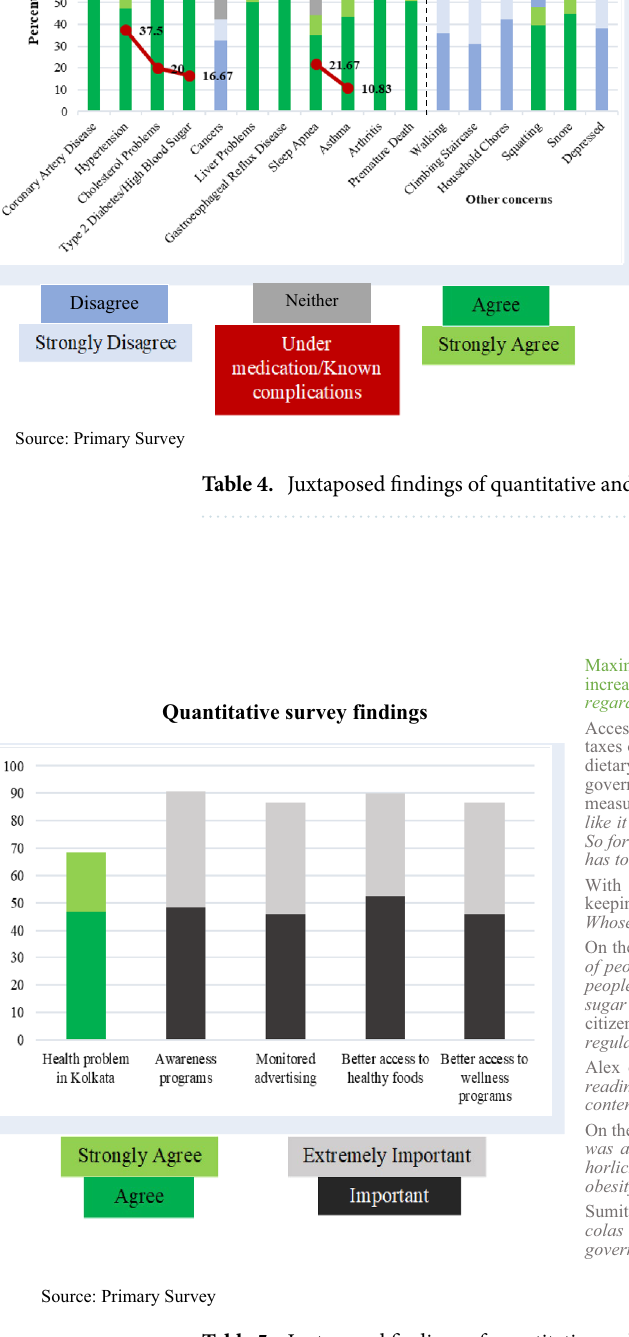
Table 5. Juxtaposed findings of quantitative and qualitative investigation on preventing obesity.